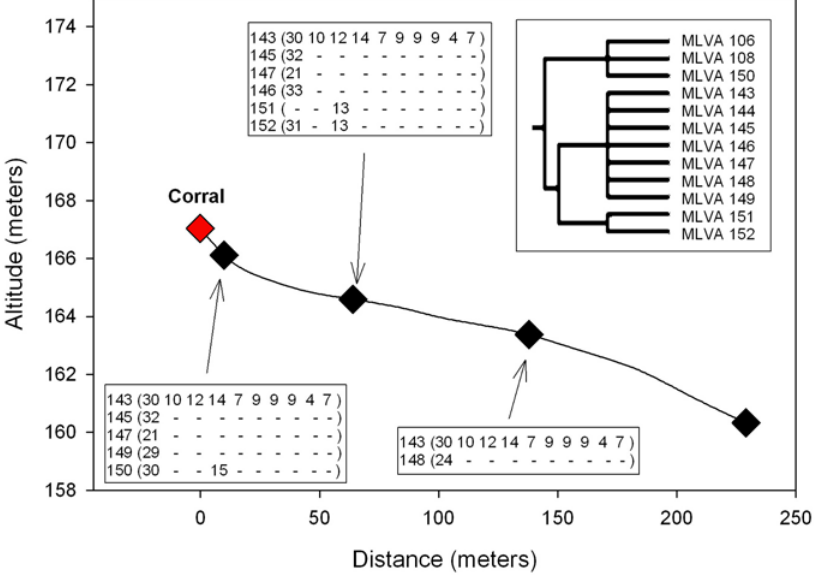
Figure 6. The persistence and transport of EcO157 in a stream in an elevated area near a point source. The change in stream elevation is indicated as a function of the distance from a corral with cattle. Sampling positions are indicated by: X ; different MLVA types isolated from each location are indicated. The inset shows a phylogenetic tree designating the relationship among the MLVA types isolated in this study (see Figure 7 and Table S1 for more detail).